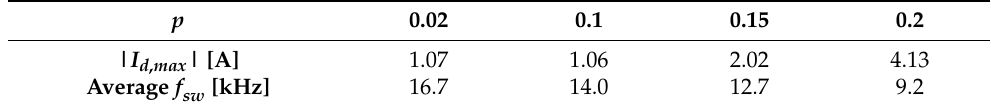
Table 4. Influence of p on the control